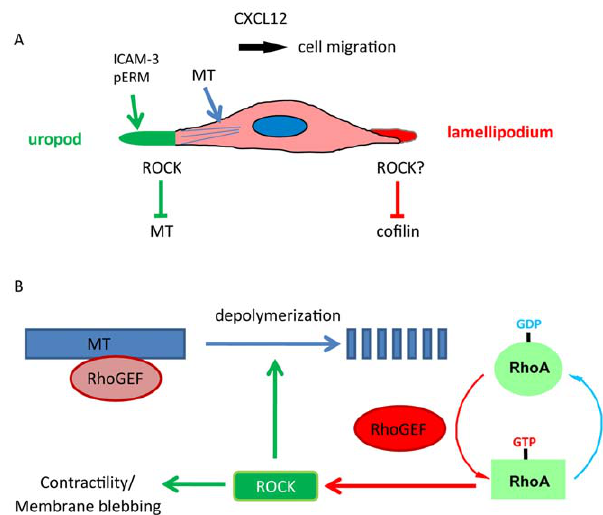
Figure 10. Model for roles of microtubules and ROCKs in T-cell polarity and migration. (A) T cell migration is stimulated by CXCL12. Migrating T cells have a lamellipodium at the front and uropod with uropod-localized proteins (e.g. ICAM-3, phosphorylated ERM proteins) at the back. Our results suggest that ROCKs reduces MT stability in the uropod and could inhibit cofilin activity in the lamellipodium. (B) Microtubule (MT) depolymerization, for example by nocodazole, releases a RhoGEF for RhoA, which increases the level of GTP-bound active RhoA. RhoA then stimulates ROCKs, which stimulate contractility and membrane blebbing and decreases microtubule stability. Inhibition of ROCKs reduces blebbing, increases stable MT, and reduces cofilin phosphorylation, thereby restoring lamellipodial/uropod